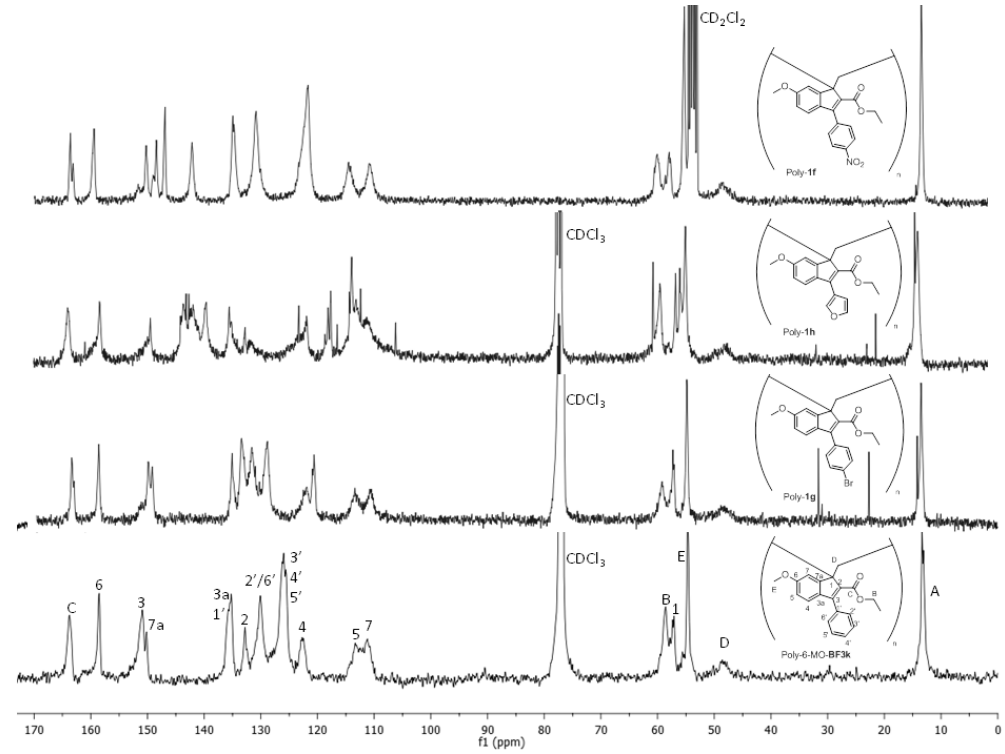
Figure 6. Comparison of the 13 C NMR spectrum of the previously reported poly-6-MO- BF3k with those of the new polymers poly- 1g , h (CDCl 3 ) and poly- 1f (CD 2 Cl 2 ).